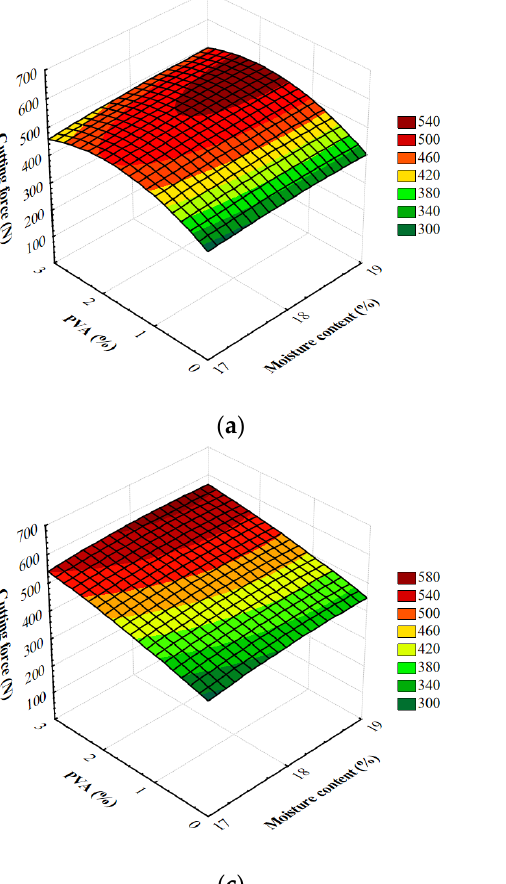
Table 4. Statistical analysis of the effect of variation source and its interactions on the cutting force (CF) of starch-based foams. Variation Source df Sum of Squares Mean Squares F 0 test p (F > F 0 )